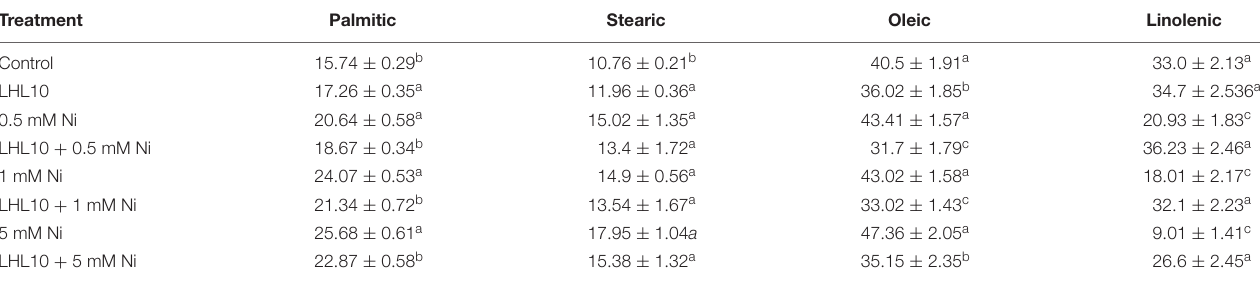
TABLE 4 | Regulation of fatty acids by Paecilomyces formosus LHL10 in soybean under Ni- stress. Treatment Palmitic Stearic Oleic Linolenic